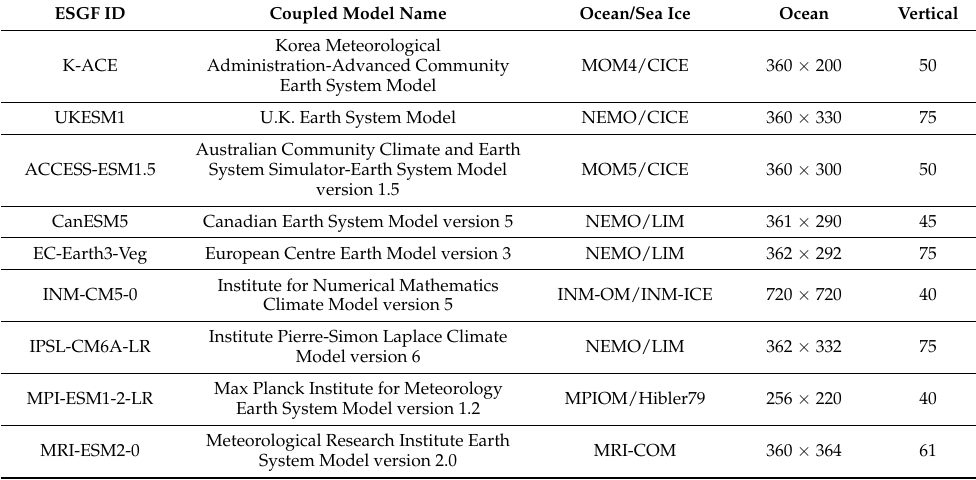
Table 1. List of 9 CMIP6 models used in this